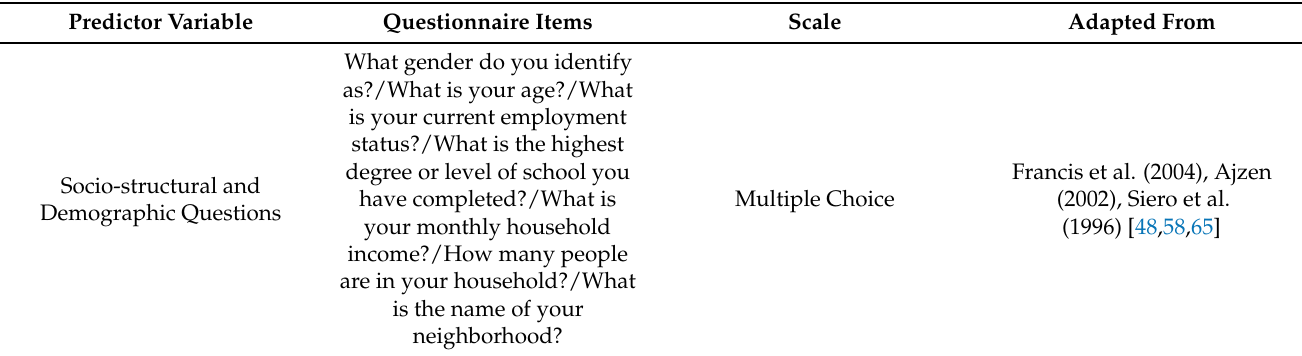
Table 5. Socio-structural and Demographic Questions (the table was created by using resource of Ajzen and Fishbein, 2005 [51]).